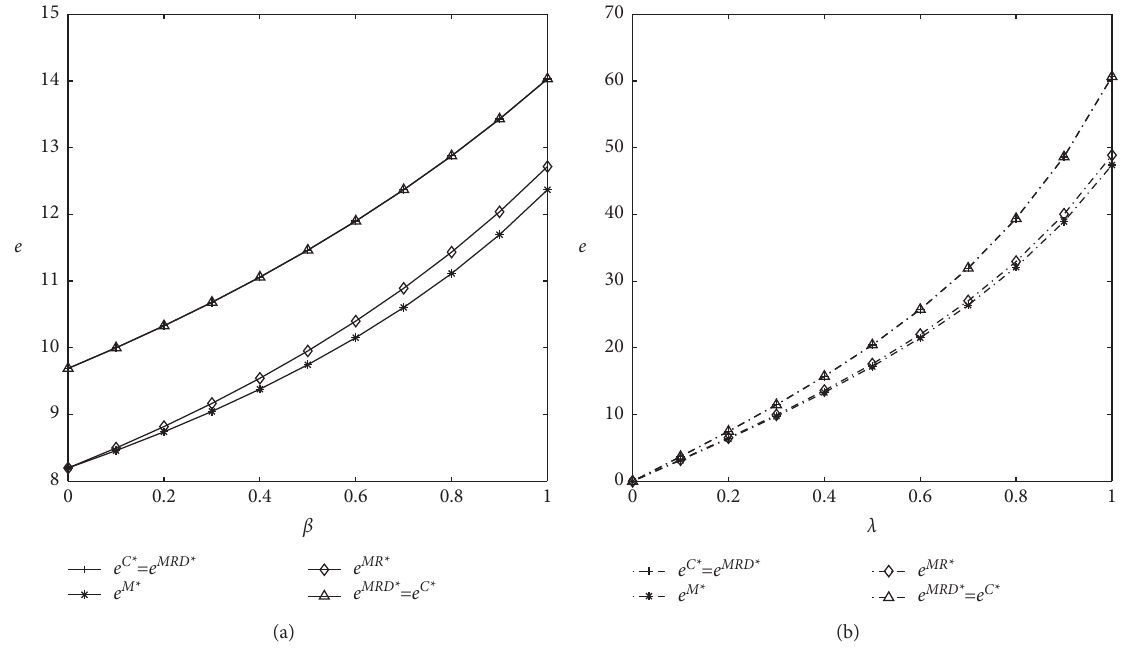
Figure 1: The effect of β and λ on the product green level.